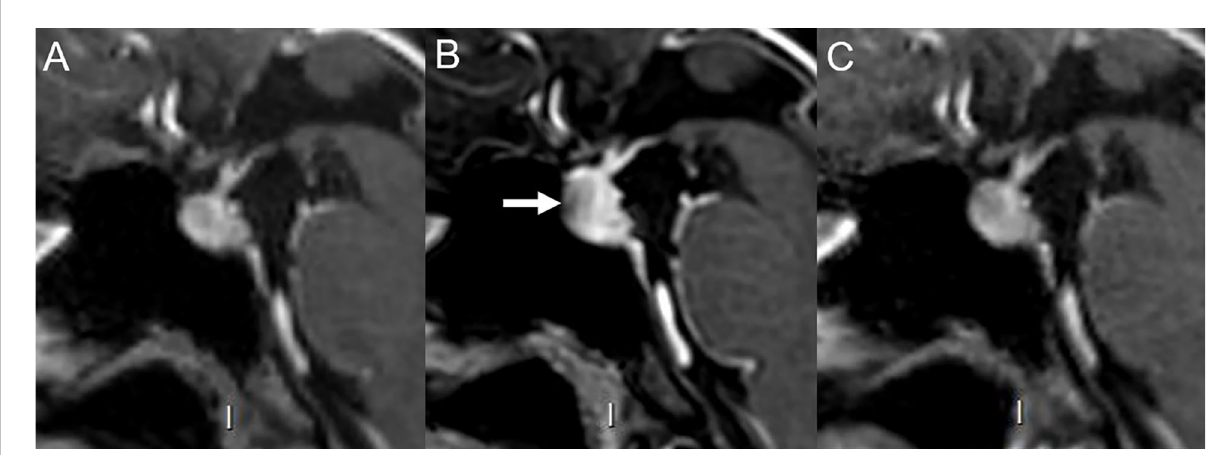
FIGURE 9 Immune-related hypophysitis in a 43-year-old female with cutaneous melanoma treated with ipilimumab and nivolumab. (A) Normal hypophyseal MRI performed 4 months prior to immunotherapy. After 3 cycles of ipilimumab (anti-CTLA-4) and nivolumab (anti-PD-1), the patient developed headaches. (B) MRI revealed increased hypophyseal height with mild pituitary stalk thickening and reduced opto-chiasmatic cistern size compatible with hypophysitis (arrow). Ipilimumab was discontinued and 2 more cycles of nivolumab alone were administered. Eventually, nivolumab